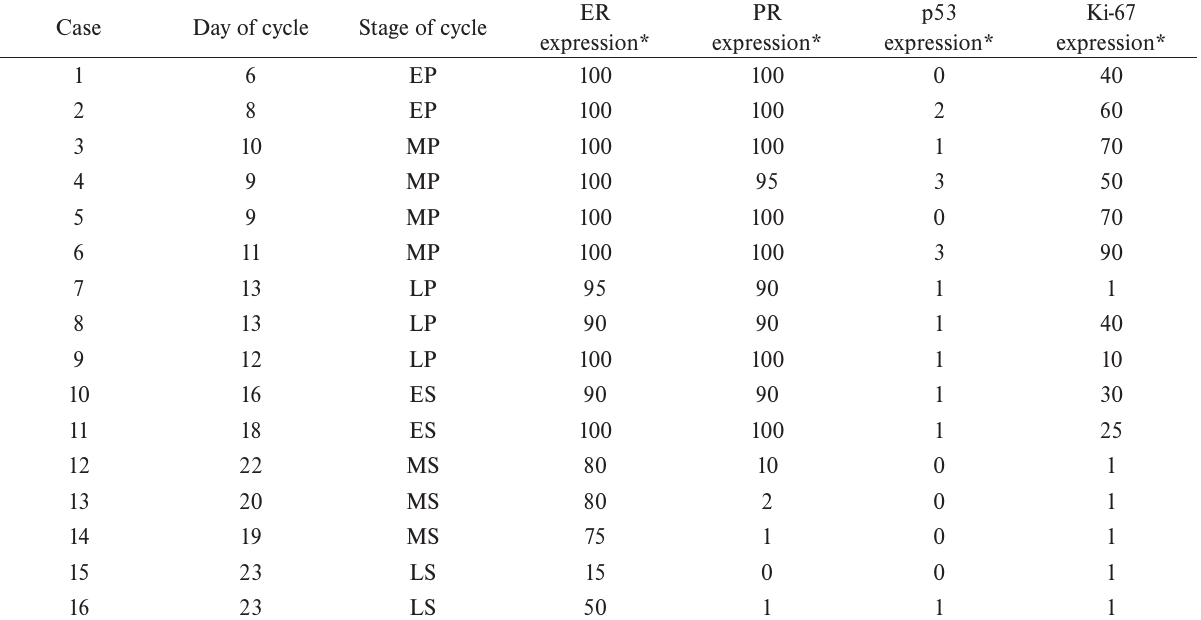
Table 3. Immunohistochemical analysis of oestrogen and progesterone receptor, p53 and Ki-67 expression in eutopic endometrium (control